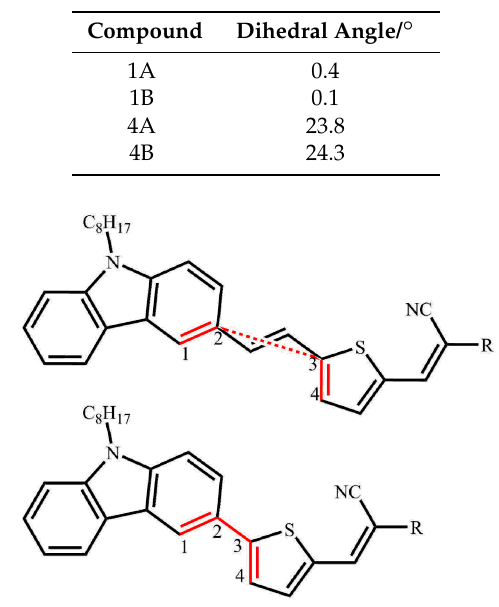
Figure 6 . Depiction of dihedral angle between carbazole and thiophene units for 1A / 1B and 4A / 4B .